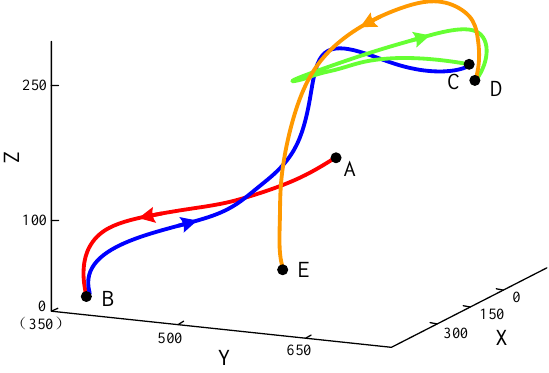
Figure 10. Schematic diagram of robot segmentation.